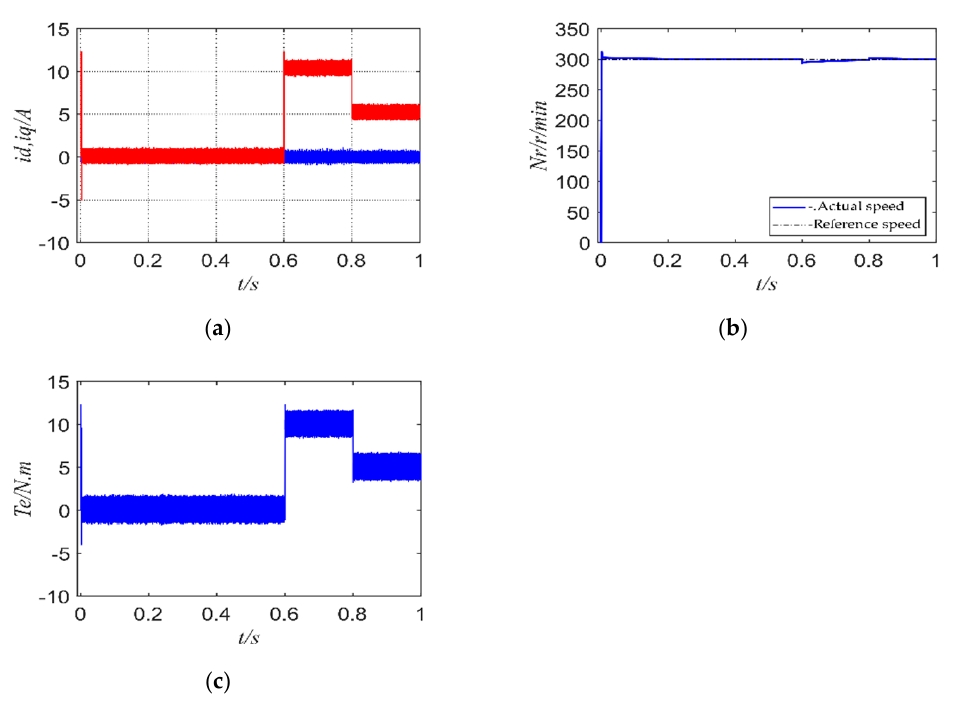
Figure 15. FCS-MPCC simulation results under parameter perturbation: ( a ) dq- axis current of FCS- MPCC; ( b ) speed of FCS-MPCC; ( c ) torque of FCS-MPCC.